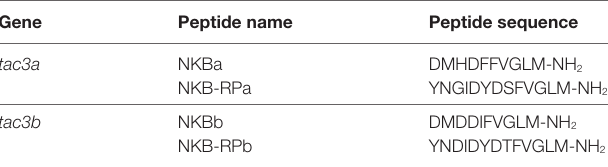
TaBle 1 | Sequences of European eel ( Anguilla anguilla ) predicted TAC3